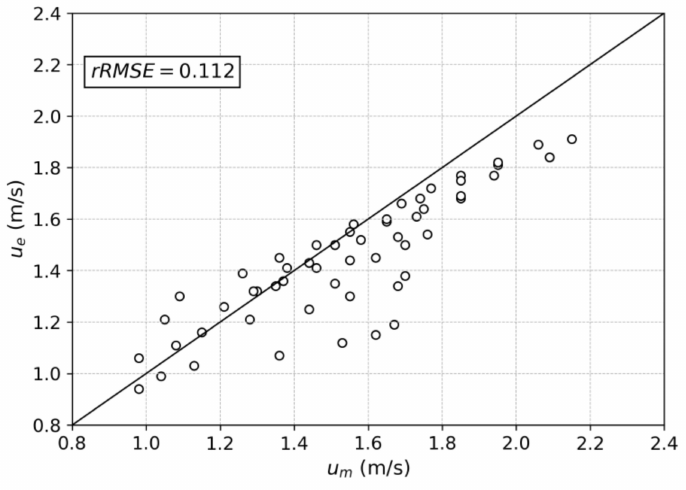
Figure 9. Comparison of the measured OFV and the estimation using c A , u = 1.21 and γ f =